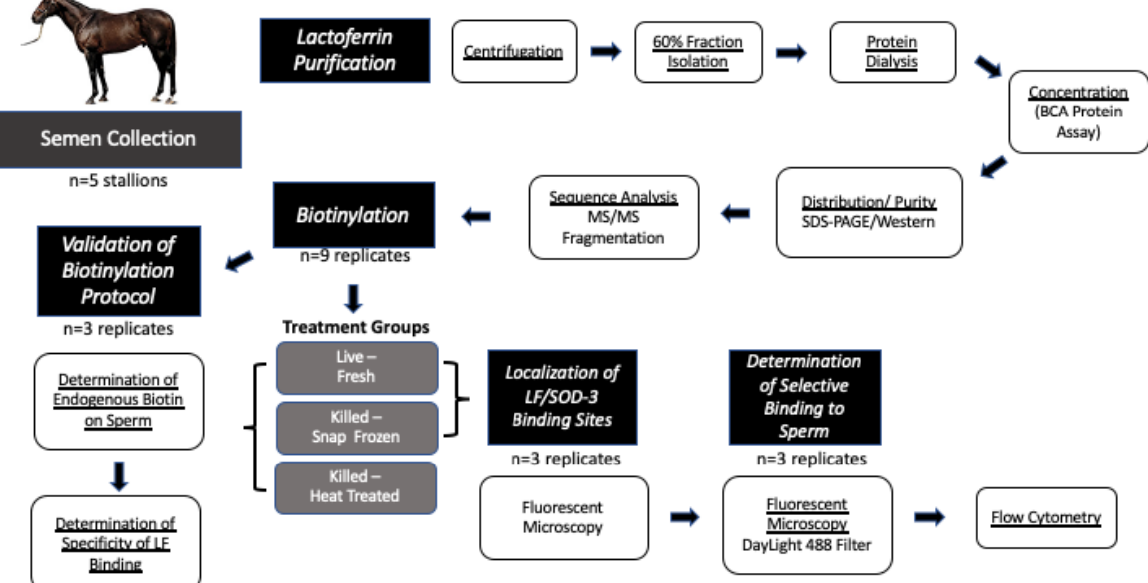
Figure 1. Summary of experimental design. The flowchart summarizes key steps of the experimental design.